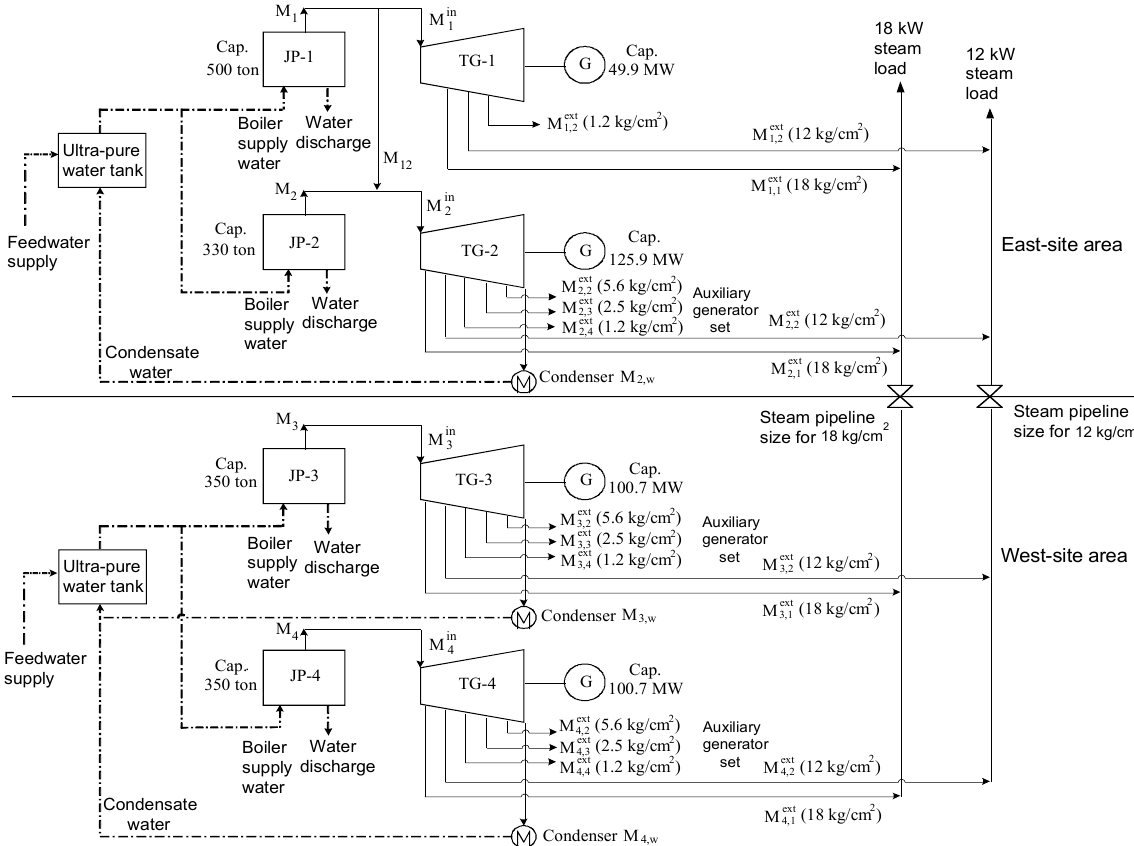
Figure 1. Simplified one-line diagram of electrical systems of the studied cogeneration